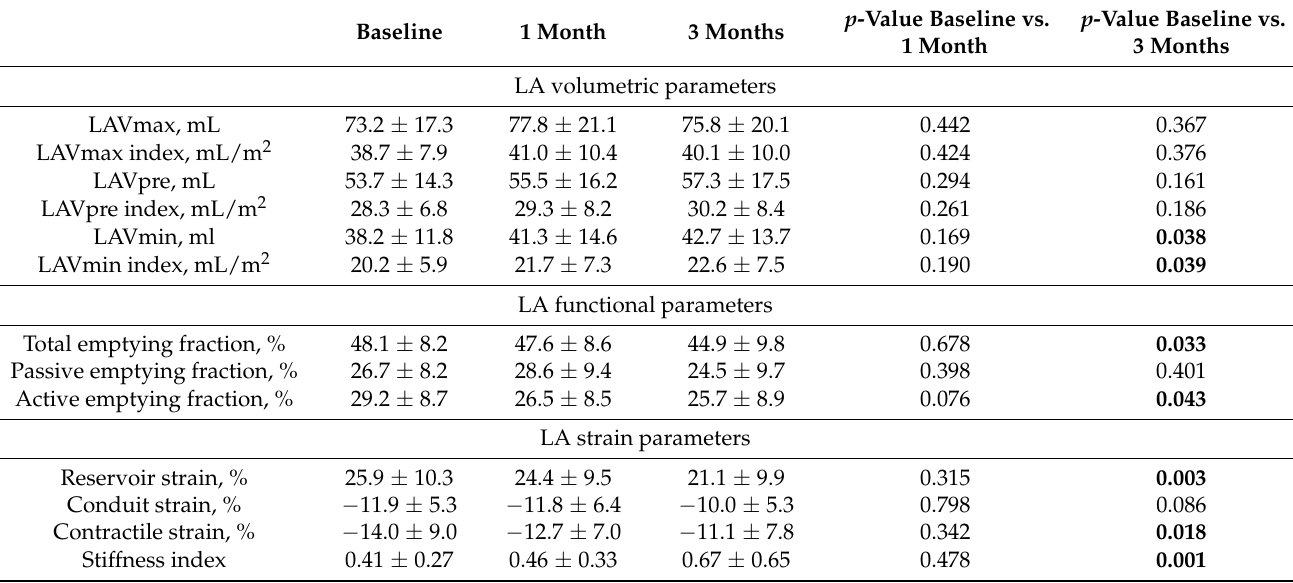
Table 4. High right atrial low right ventricular pacing group.